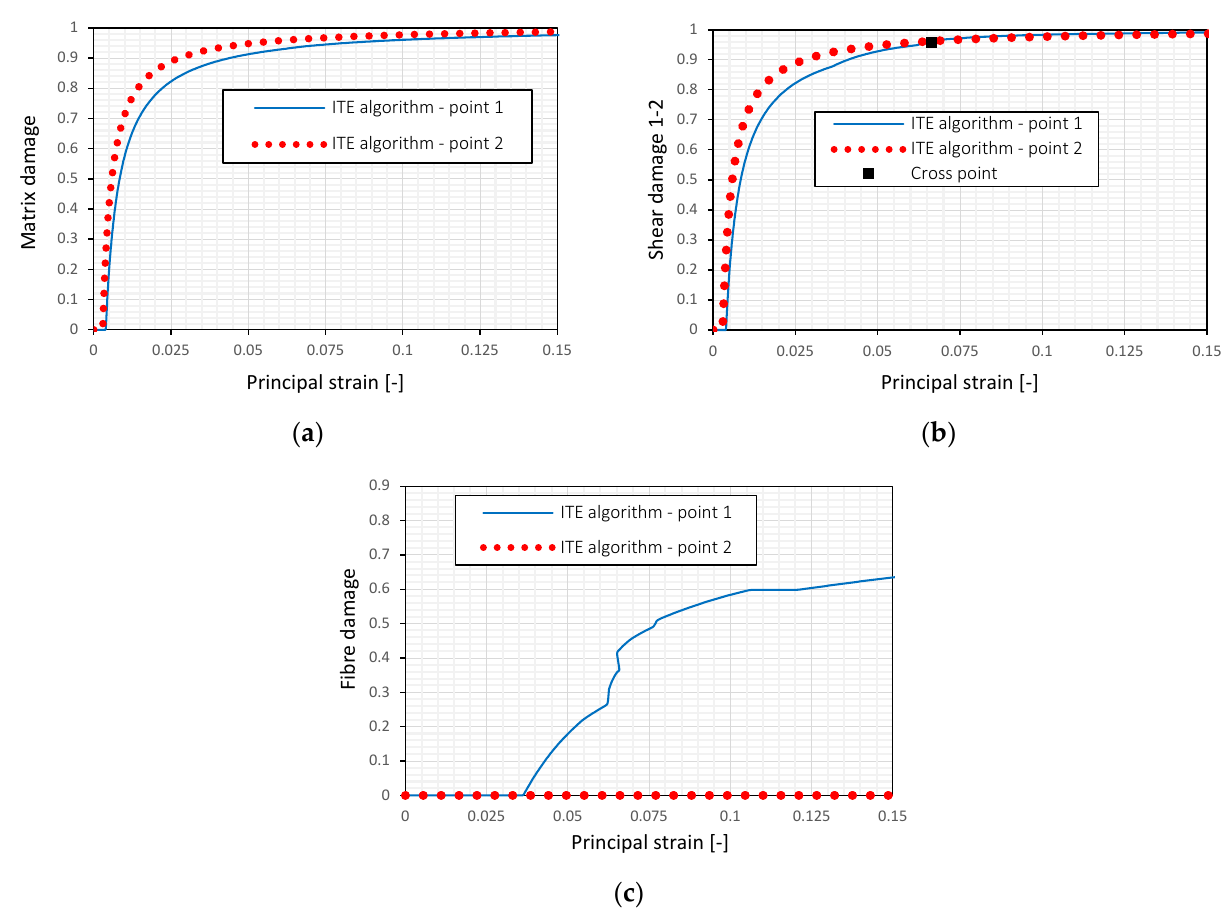
Figure 12. Identification of integration points 1 and 2 ( a ) and distribution of principal stress vs. prin- cipal strain ( b ) for the three-point bending beam.